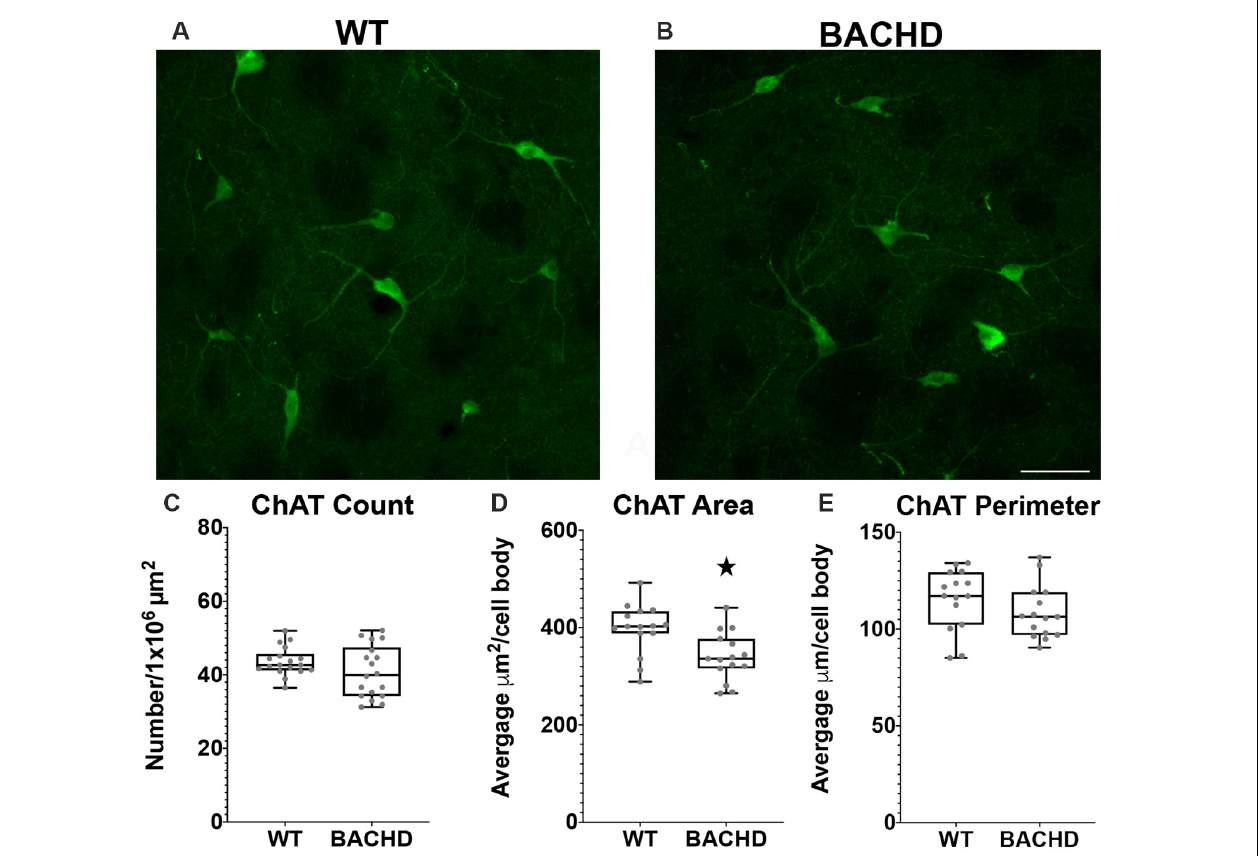
FIGURE 5 | Cholinergic interneurons have decreased cell body area in BACHD mice at 12–14 months of age. Indirect immunofluorescent staining was performed on WT (A) and BACHD (B) mice with a ChAT+ antibody to detect cholinergic cells. ChAT+ cells were not significantly altered in number ( p = 0.2482; C ). The area (D) of BACHD ChAT+ cells was significantly decreased (* p = 0.0057) without significant reduction in the perimeter ( p = 0.167) of the cells (E) . The Mann–Whitney test was used for the analyses, and n = 3 WT and n = 3 BACHD mice. Scale bar is 50 µ